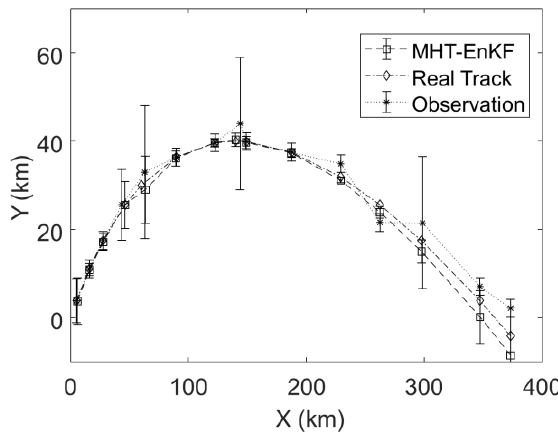
Figure 4. Comparison of the statistical information of 100 samples of the MHT-EnKF fitting result with the actual multi-source observation data.